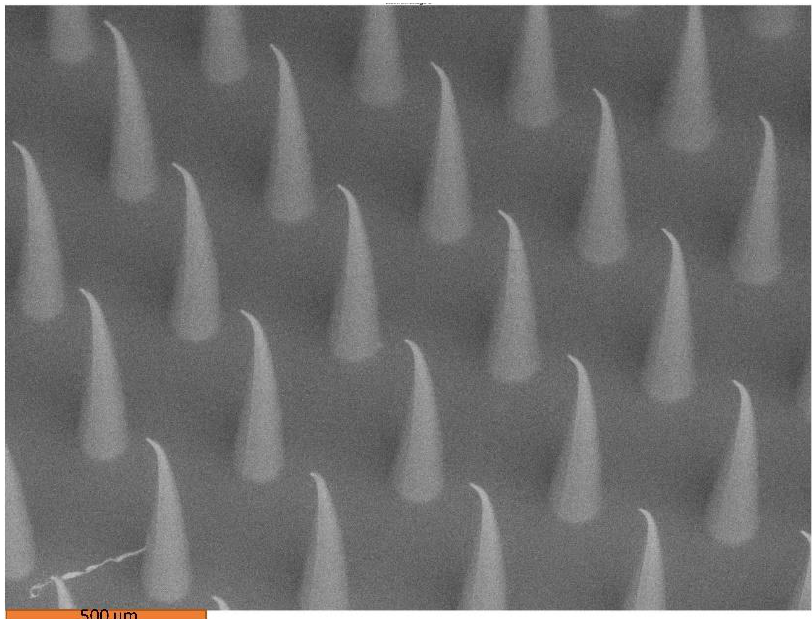
Figure 1. Scanning electron microscope image of amphotercin B –Gantrez™ microneedles with buckled tips.